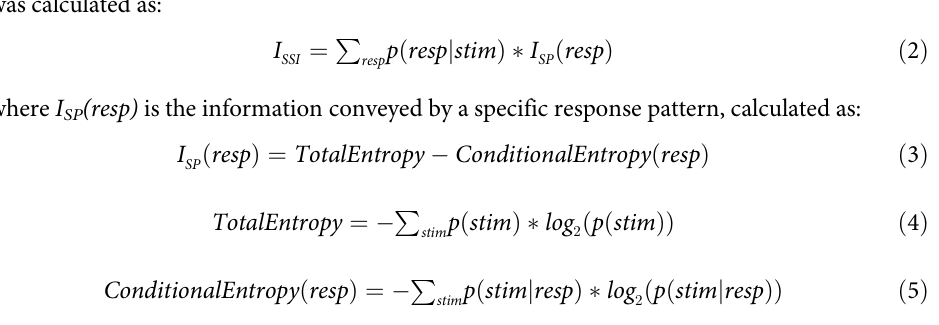
S1 Fig. Mutual information analyses performed across a range of analysis window